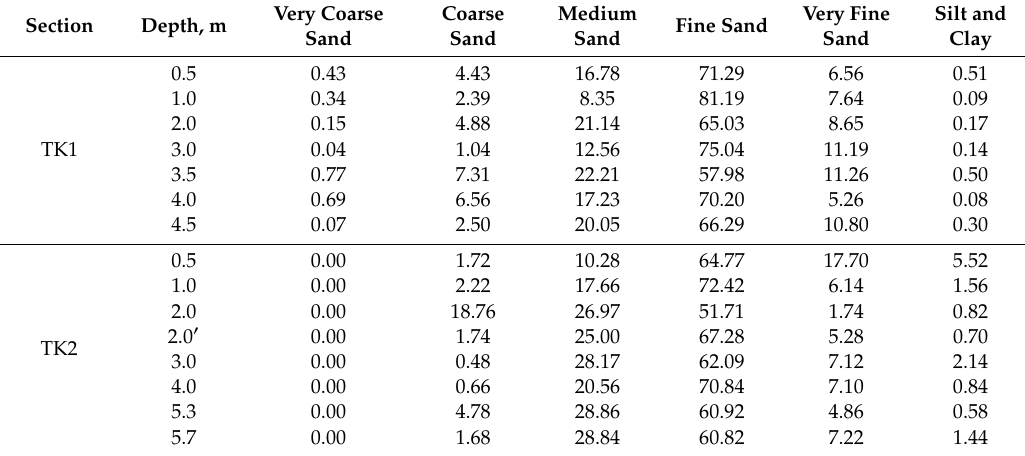
Table 1. Grain-size composition (%) of the studied